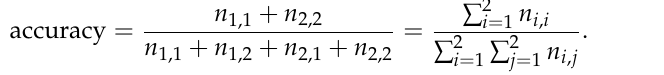
Figure 8. A scheme of one neuron in l -th layer, gaining signals of a form Σ = w T w l − 1,1 z l − 1,1 + w l − 1,2 z l − 1,2 + w l − 1,3 z l − 1,3 from ( l − 1 ) -th layer and transcending signal of a form